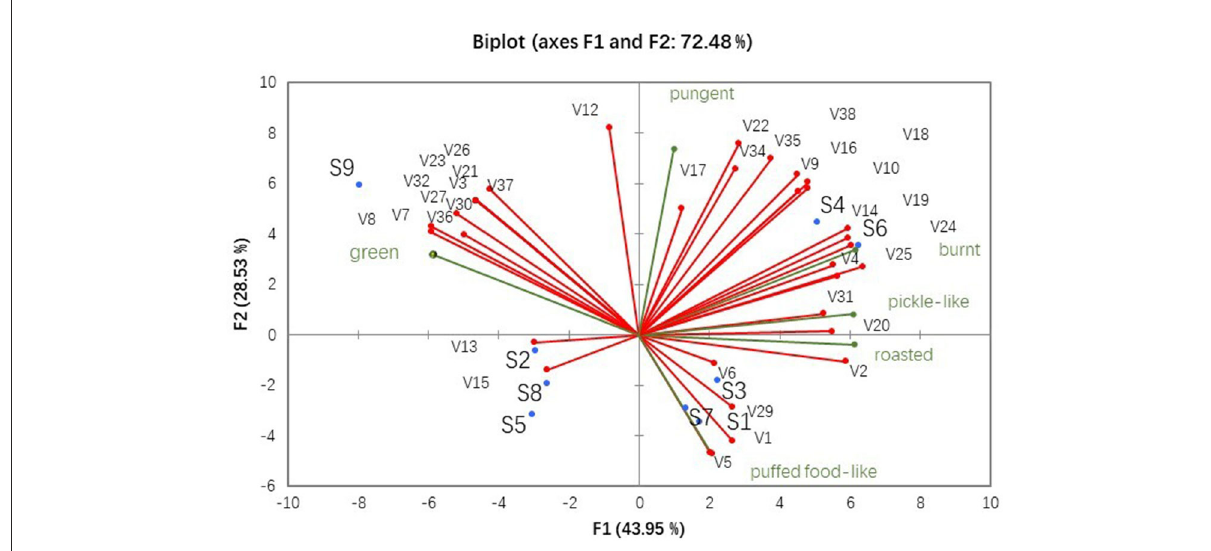
FIGURE3 PCA analysis of nine fragrant rapeseed oils based on aroma compounds and sensory